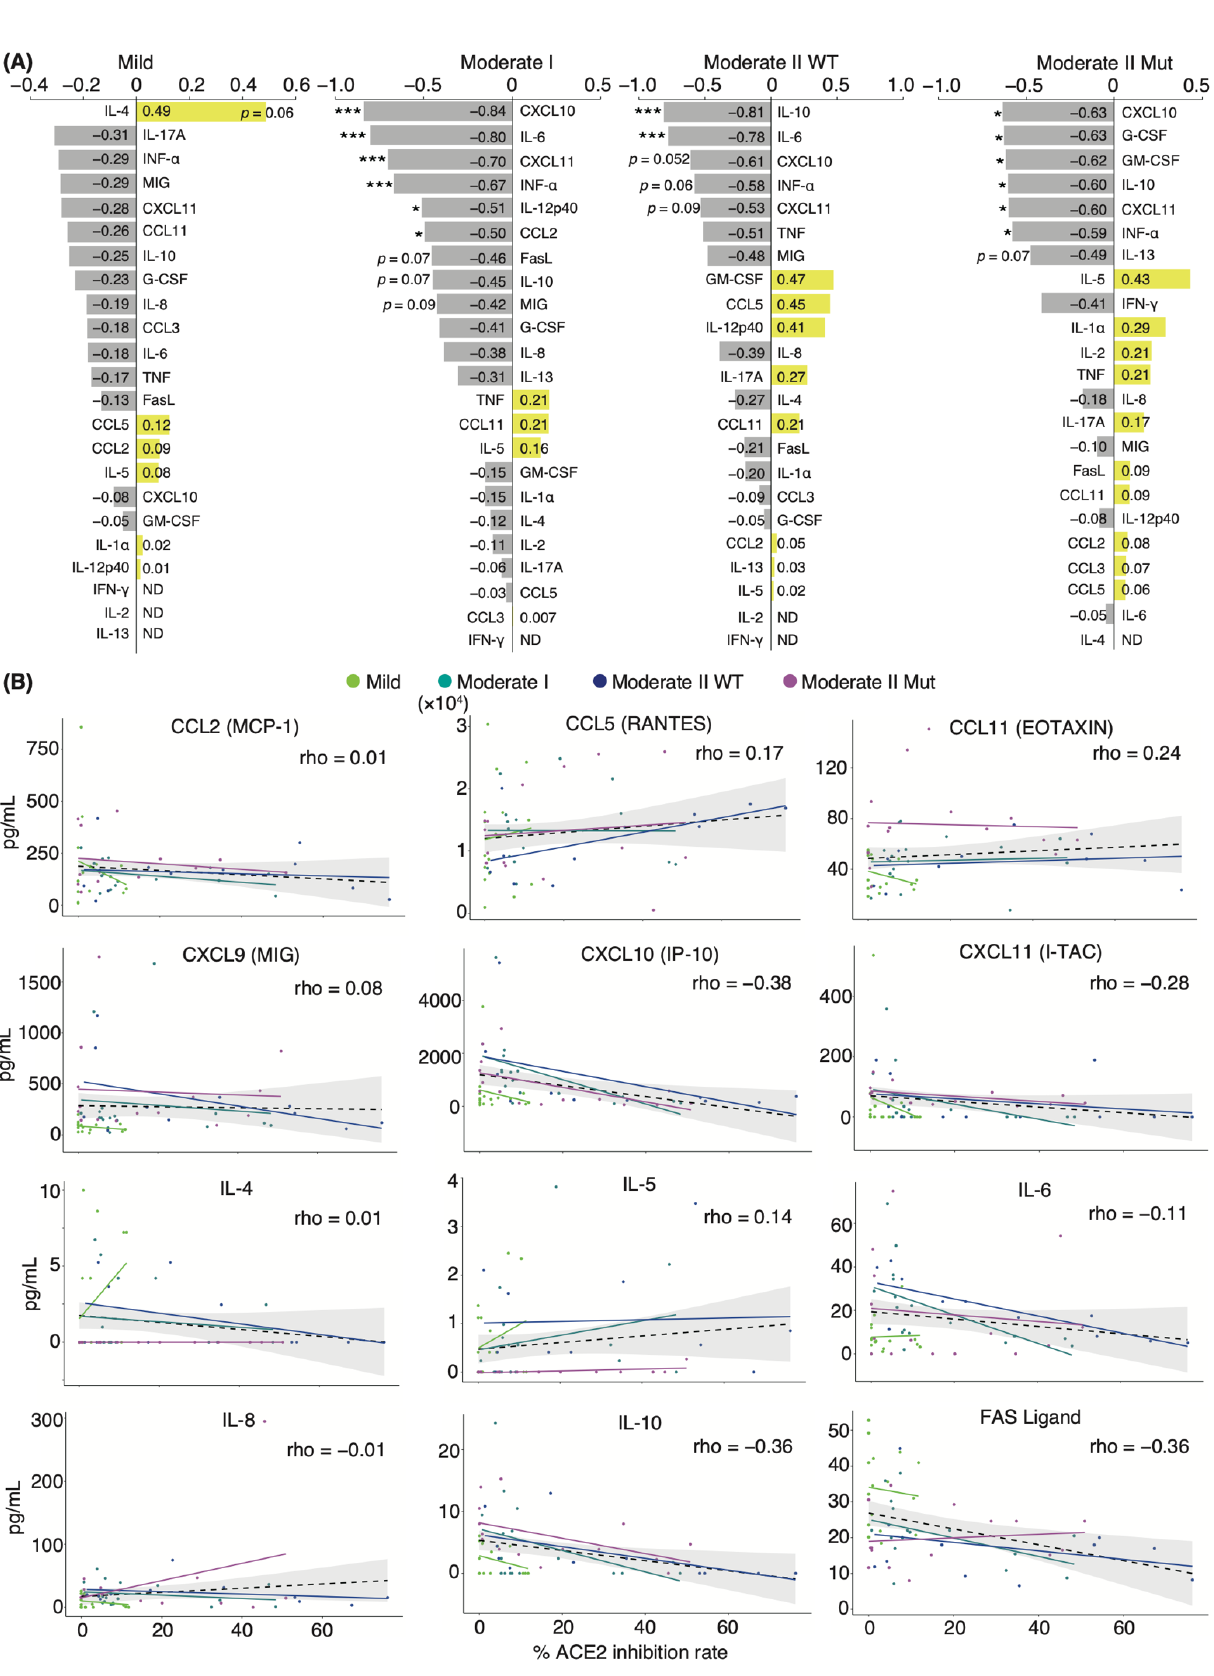
Figure 3. Correlation analyses of serum cytokine levels and neutralizing antibody titer against WT in COVID-19 patients: ( A ) Graphs show Spearman’s correlation coefficients of each severity between serum neutralizing antibody titer and individual cytokine levels ( n = 9 patients/mild